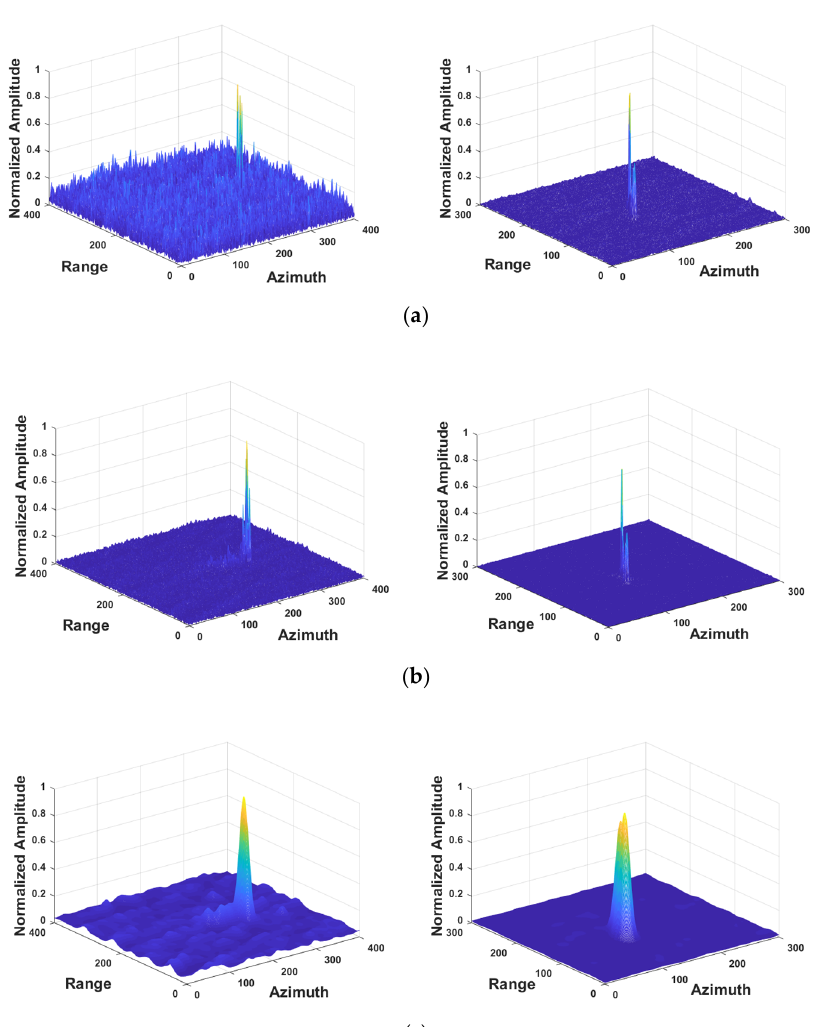
Figure 15. Normalized amplitude of the two detected targets: ( a ) HH amplitude; ( b ) HV amplitude; ( c ) reflection symmetry metric. Table 6. SCRs (unit: dB) of the two detected ship targets in different polarimetric parameter images.